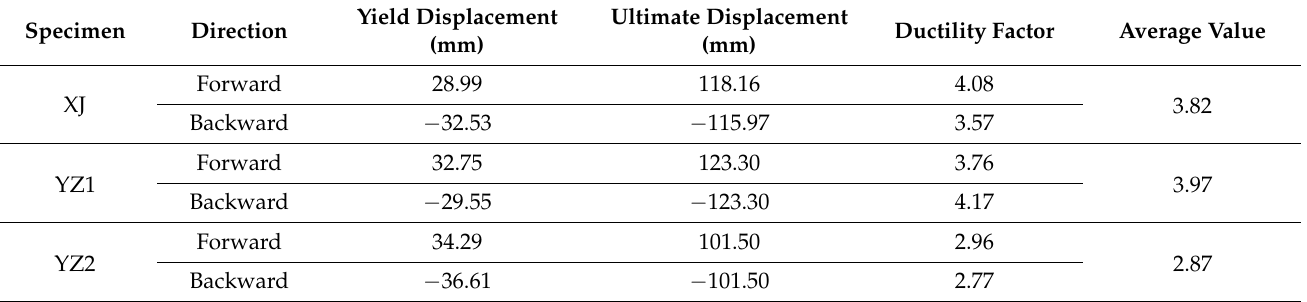
Table 4. The deformation